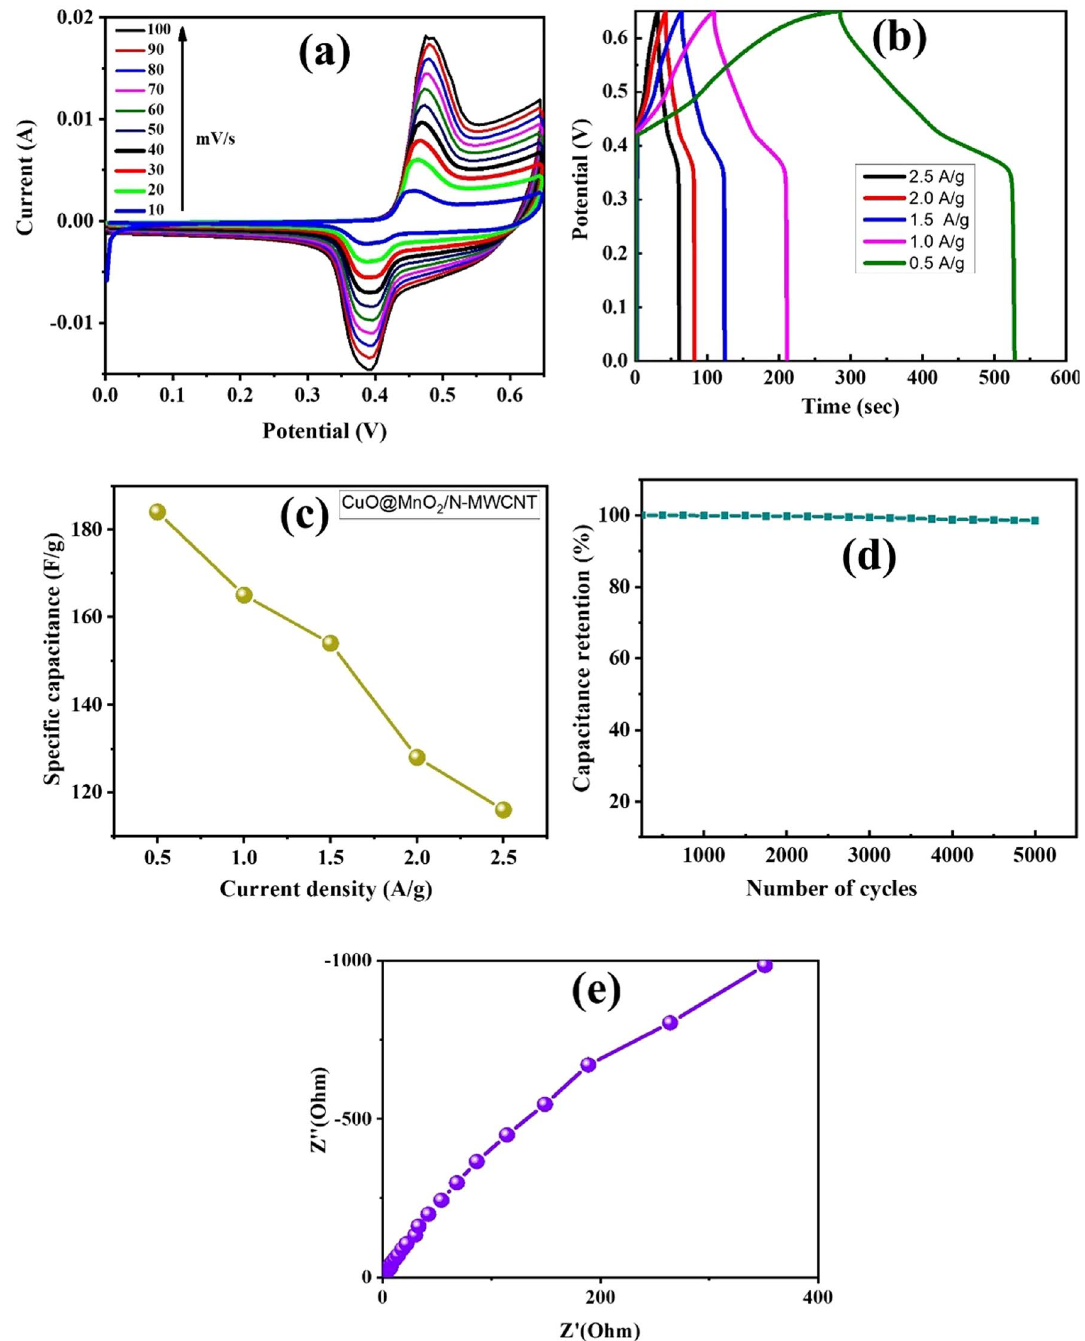
Figure 6. Results of electrochemical CV analysis. ( a ) CV; ( b ) GCD; ( c ) variation of specific capacitance with current density; ( d ) cyclic stability; and ( e ) EIS of the CuO@MnO 2 /N-MWCNT composite